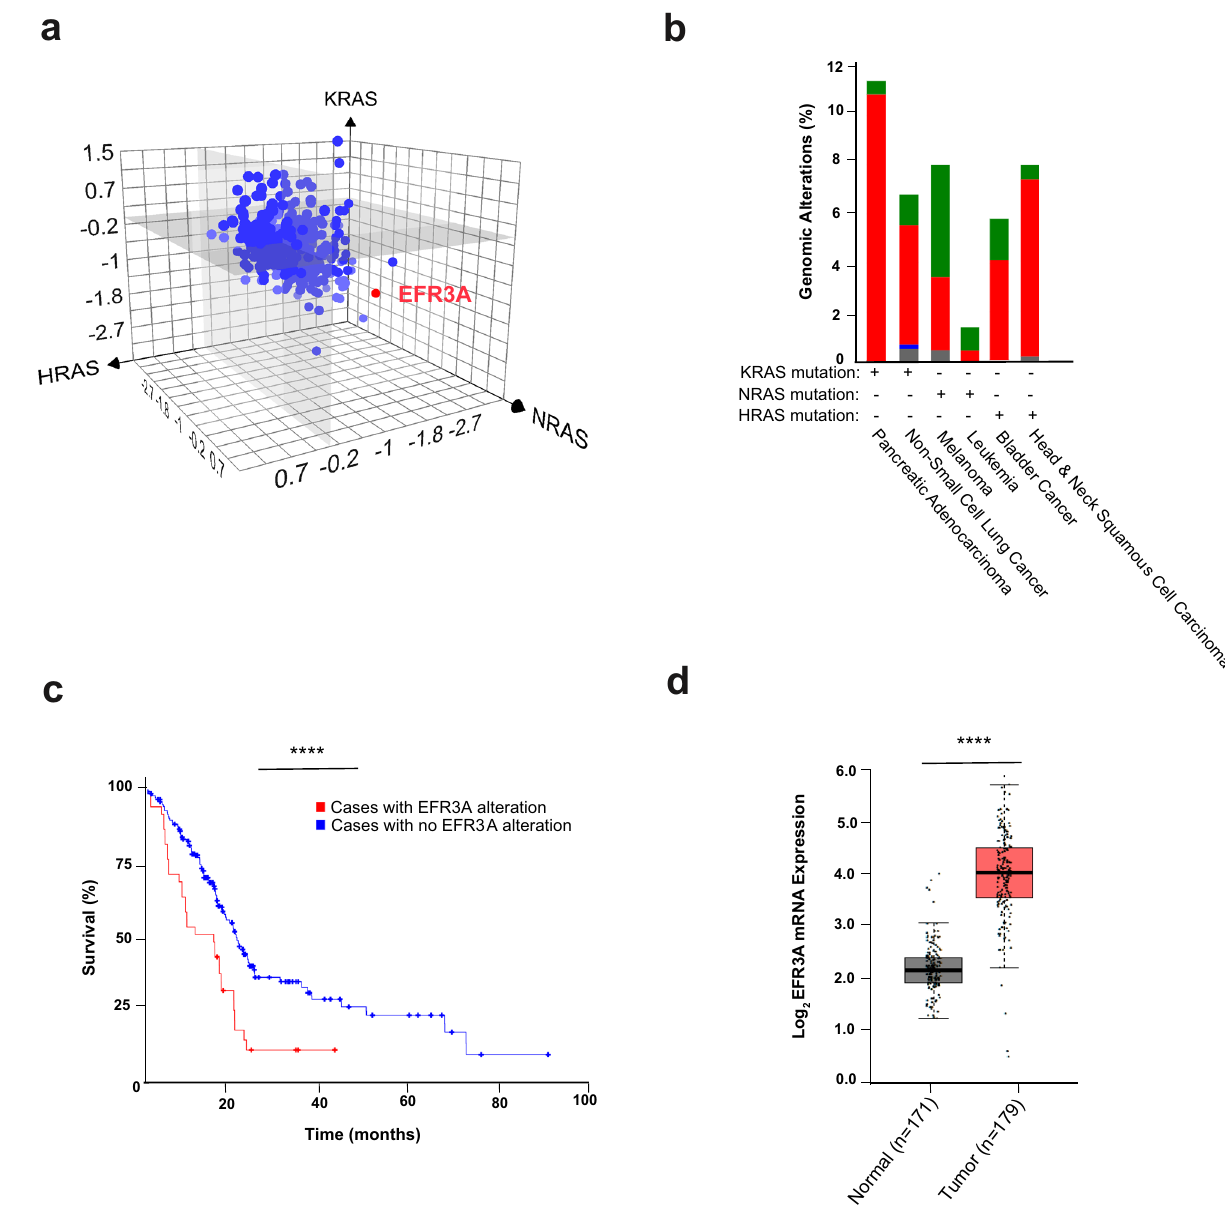
Fig. 1 Identi fi cation of EFR3A as a potential vulnerability in KRAS-mutant pancreatic cancer. a Mean log 2 fold-enrichment of the 5 sgRNAs targeting each of the 474 genes encoding proteins of the RAS interactomes (determined by BirA-mediated proximity labeling) in the isogenic background of HEK-HT cells transformed by oncogenic (G12V) HRAS ( x -axis), KRAS ( y -axis), or NRAS (z-axis). b The frequency (%) that the EFR3A gene exhibits ampli fi cation and copy number variation (red bar), a point mutation (green bar), deletion (blue bar), or multiple alterations (gray bar) in 6 different RAS-mutant cancers from the cBiportal PanCan TCGA dataset. Only cancers with ≥ 2% genomic alterations are shown. c A Kaplan – Meier plot of overall survival of pancreatic adenocarcinoma cases with ( n = 42) versus without ( n = 327) a genomic alteration in EFR3A ( p = 2.034e – 4), as determined from 5 pancreatic cancer datasets (ICGC, Nature 2012; TCGA PanCancer Atlas; UTSW Pancreatic Cancer; TCGA Firehose Legacy; QCMG, and Nature 2016), p = 0.01504. d A boxplot of the log 2 mRNA expression of EFR3A , normal max (3.1), min (1.3), center (2.2); tumor max (4.5), min (0.3), center (4.2) in 179 pancreatic adenocarcinoma versus 171 normal tissues based on GEPIA analysis of the PAAD dataset. Signi fi cance values calculated by one-sided logrank test for ( c ) and one-way ANOVA analysis for ( d ): **** p < 0.0001. Percentiles in the box plots pre-set at 50% (higher) and 50%